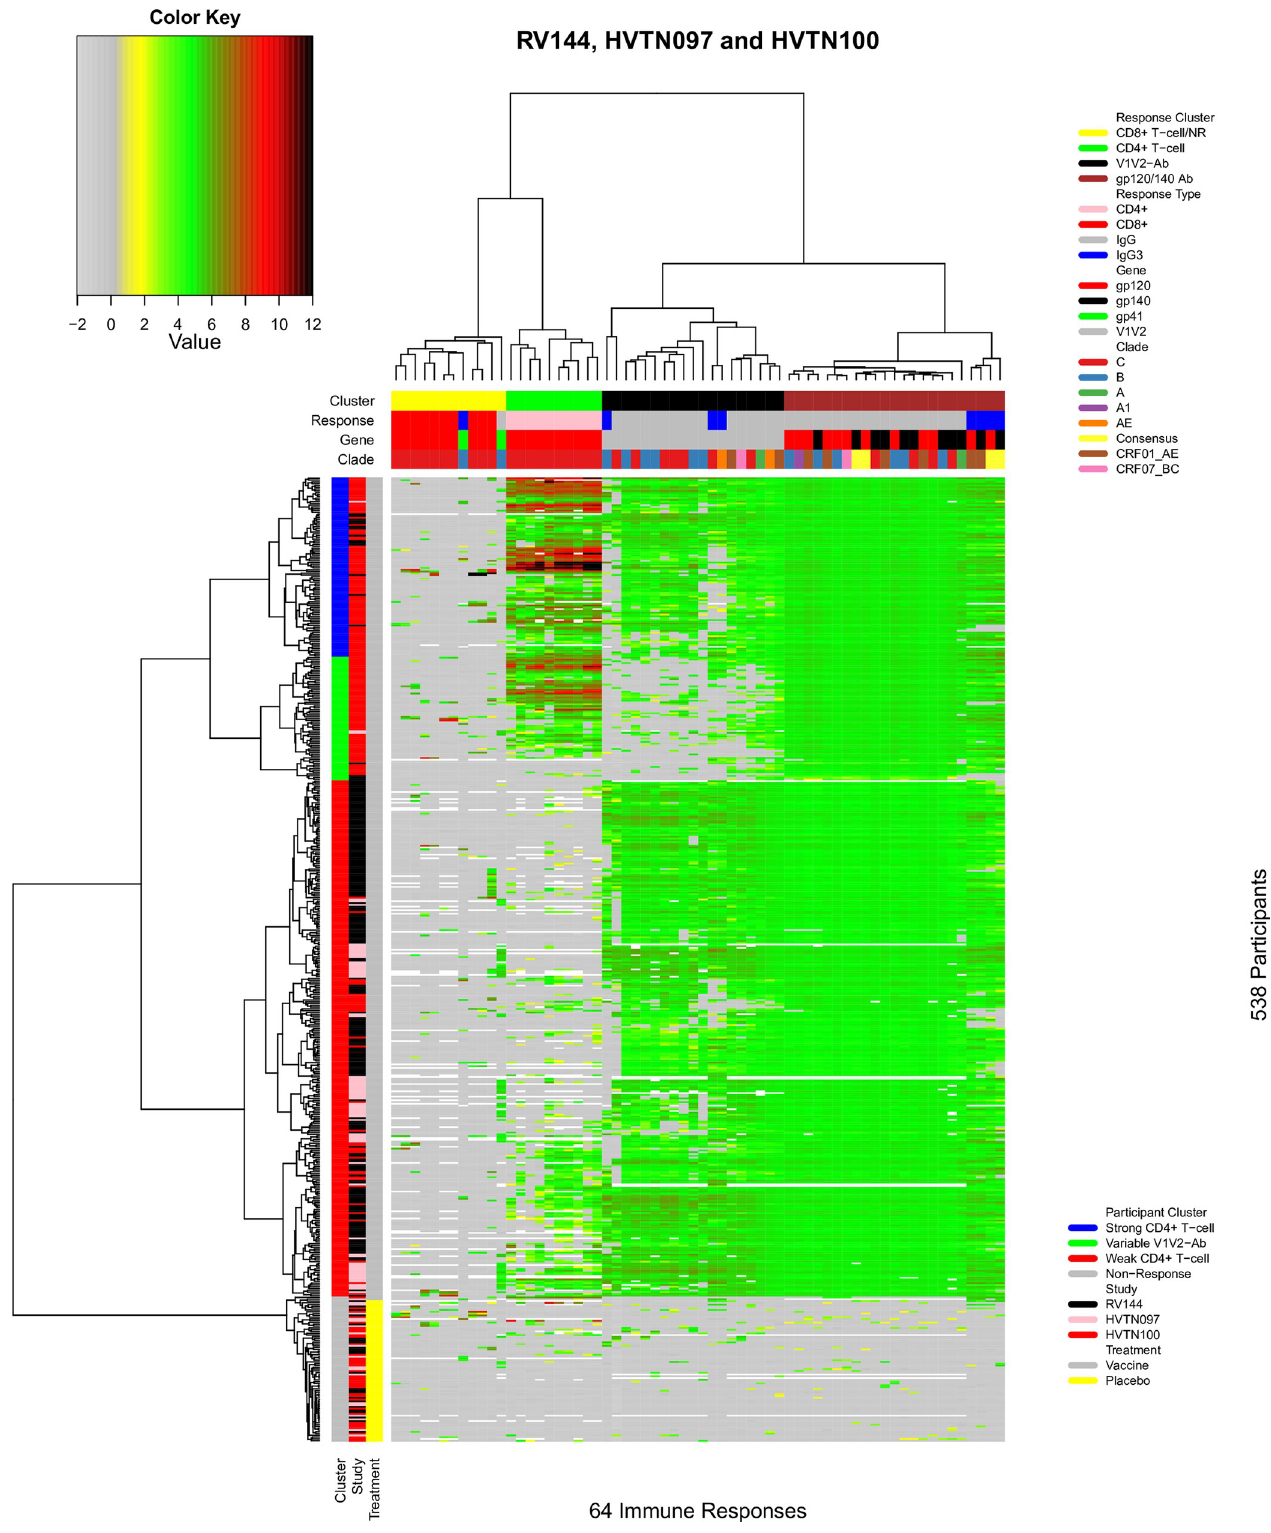
Fig 1. Landscape of immune responses to the P AE/B /alum and P C /MF59 regimens. The heatmap was generated by two-way hierarchical clustering of participants and immune response variables based on their similarity after bi-directional power transformation of the immune response measurements. The 64